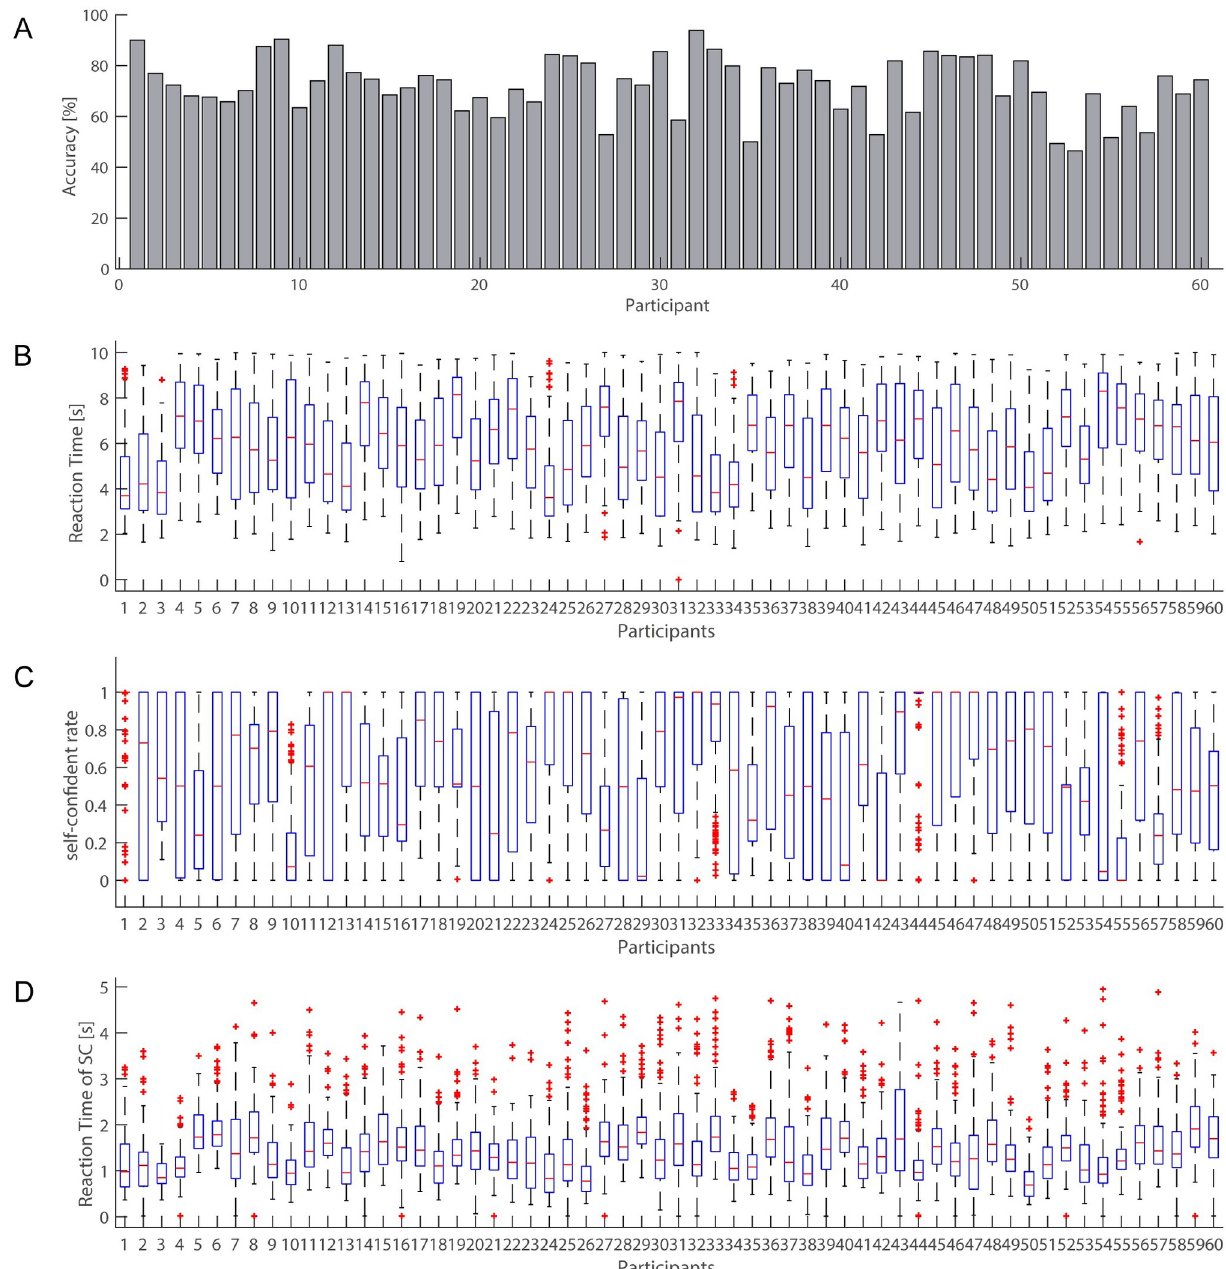
Fig 3. Behavioral result. (A) Averaged accuracy. (B) Averaged reaction time. (C) Averaged SCR. (D) Averaged reaction time for SCR response.